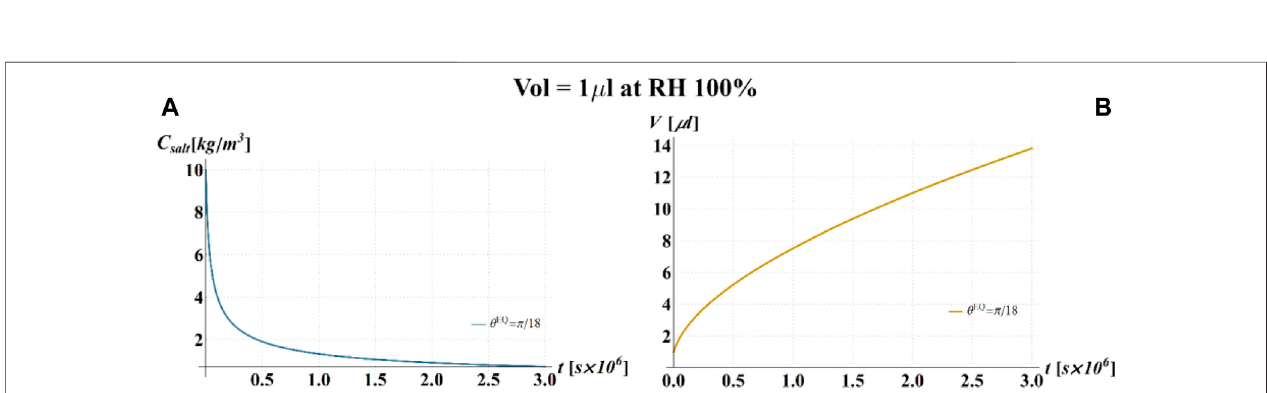
FIGURE7| Resultsofmodelsimulationsoftheevaporationprocessofasessiledropofaqueoussolutionwithastartingvolumeof1 μ L,ataRH (cid:2) 100%,intermsof timeevolutionof (A) thesaltconcentration, C salt ,and (B) thevolume, V, for fl atsurfaceswithdifferentwettability, at T (cid:2) 25 ° C.Onlythecalculationsperformedforaninitial contact angle equal to π / 18 are presented since, for the cases θ EQ (cid:2) π / 6 , θ EQ (cid:2) π / 3 , and θ EQ (cid:2) π / 2, the condition for validity of Eq. 7 , that is, 0 < θ ( t ) ≤ π / 2 is not ful fi lled during the evolution of the drop within the selected time frame of the simulation (i.e., for the 10 nL droplet, it is set to 3 × 10 6 s ).